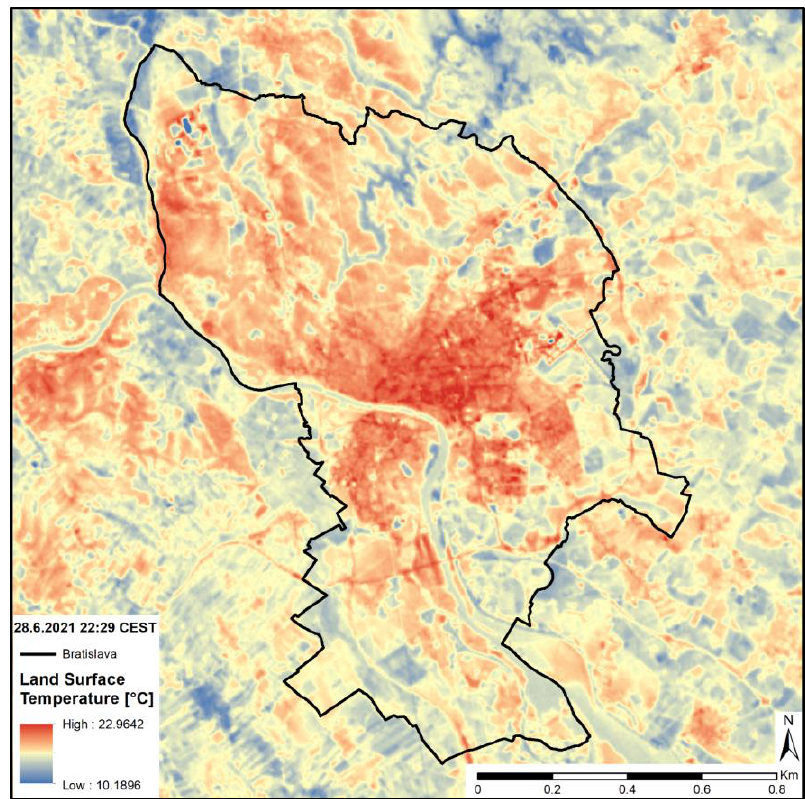
Figure 3. The night-time surface temperature of Bratislava and its surroundings.